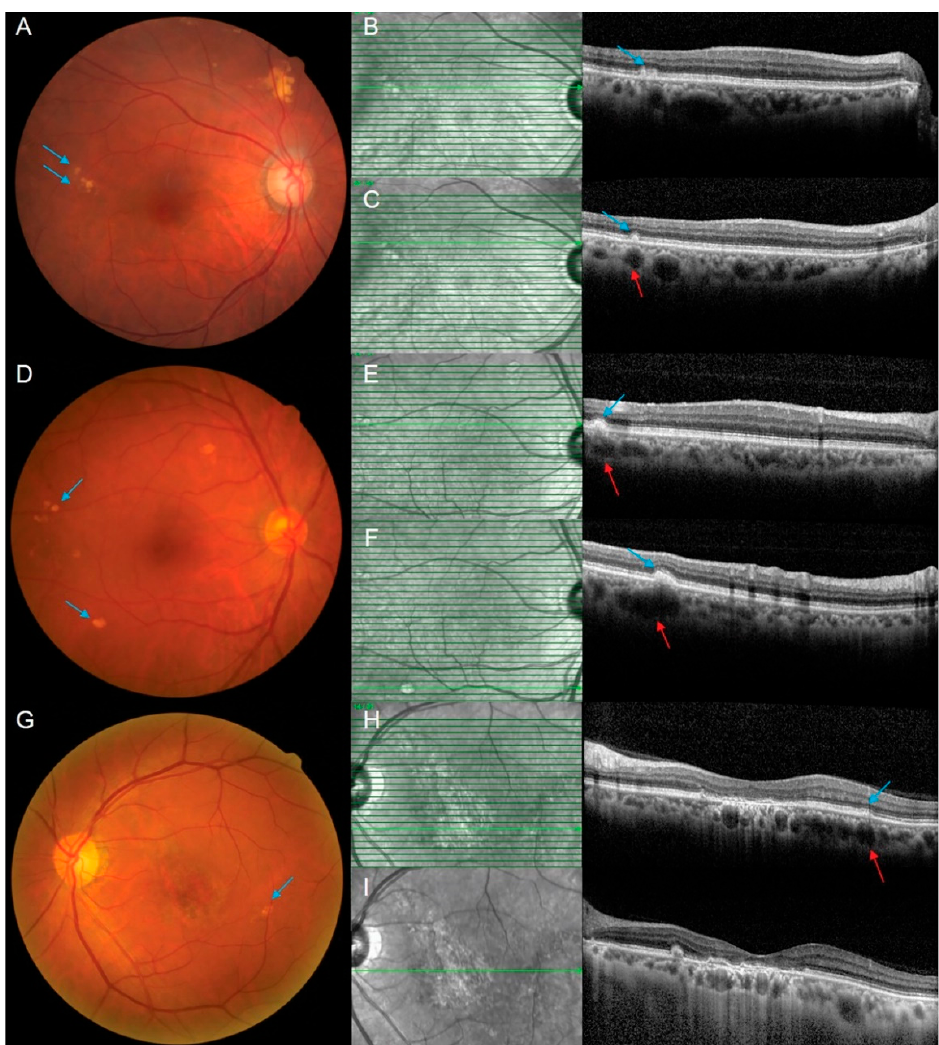
Figure 3. Representative cases of pachydrusen and pachyvessel. ( A – C ) An 80-year-old male patient diagnosed with PCV in his left eye presents with pachydrusen (blue arrows) in FP and pachydrusen and pachyvessel (red arrows) in OCT in the fellow eye. ( D – F ) A 69-year-old male patient diagnosed with PCV in his left eye presents with pachydrusen in FP and pachydrusen and pachyvessel in OCT in the fellow eye. ( G – I ) A 62-year-old male diagnosed with PCV in his left eye presents with pachydrusen in FP and pachydrusen and pachyvessel in OCT, as well as a relatively thin subfoveal choroidal thickness measured as 200 µ m in the enhanced depth imaging mode. FP = fundus photography; OCT = optical coherence tomography; PCV = polypoidal choroidal vasculopathy. The SFCT was measured as the vertical perpendicular distance from the innermost hyperreflective line of the chorioretinal interface to the hyperreflective line to the Bruch membrane in the enhanced depth imaging (EDI) mode of OCT. Considering that the mean SFCT in normal individuals is approximately 300 µ m [28], those with SFCT ≥ 300 µ m were classified as the “thick choroid” group and those with SFCT < 300 µ m as the “thin choroid” group. Color FPs were taken using an AFC-210 (NIDEK, Aichi, Japan) at a standard 45° centered on the fovea. The EDI mode was routinely obtained at the same time as the standard spectral domain OCT image (Heidelberg Spectralis OCT, Heidelberg Engineering, Heidelberg, Germany), and images were analyzed using Spectralis OCT software version 6.0. All color FP, OCT, FA, and ICGA findings were reviewed by two independent